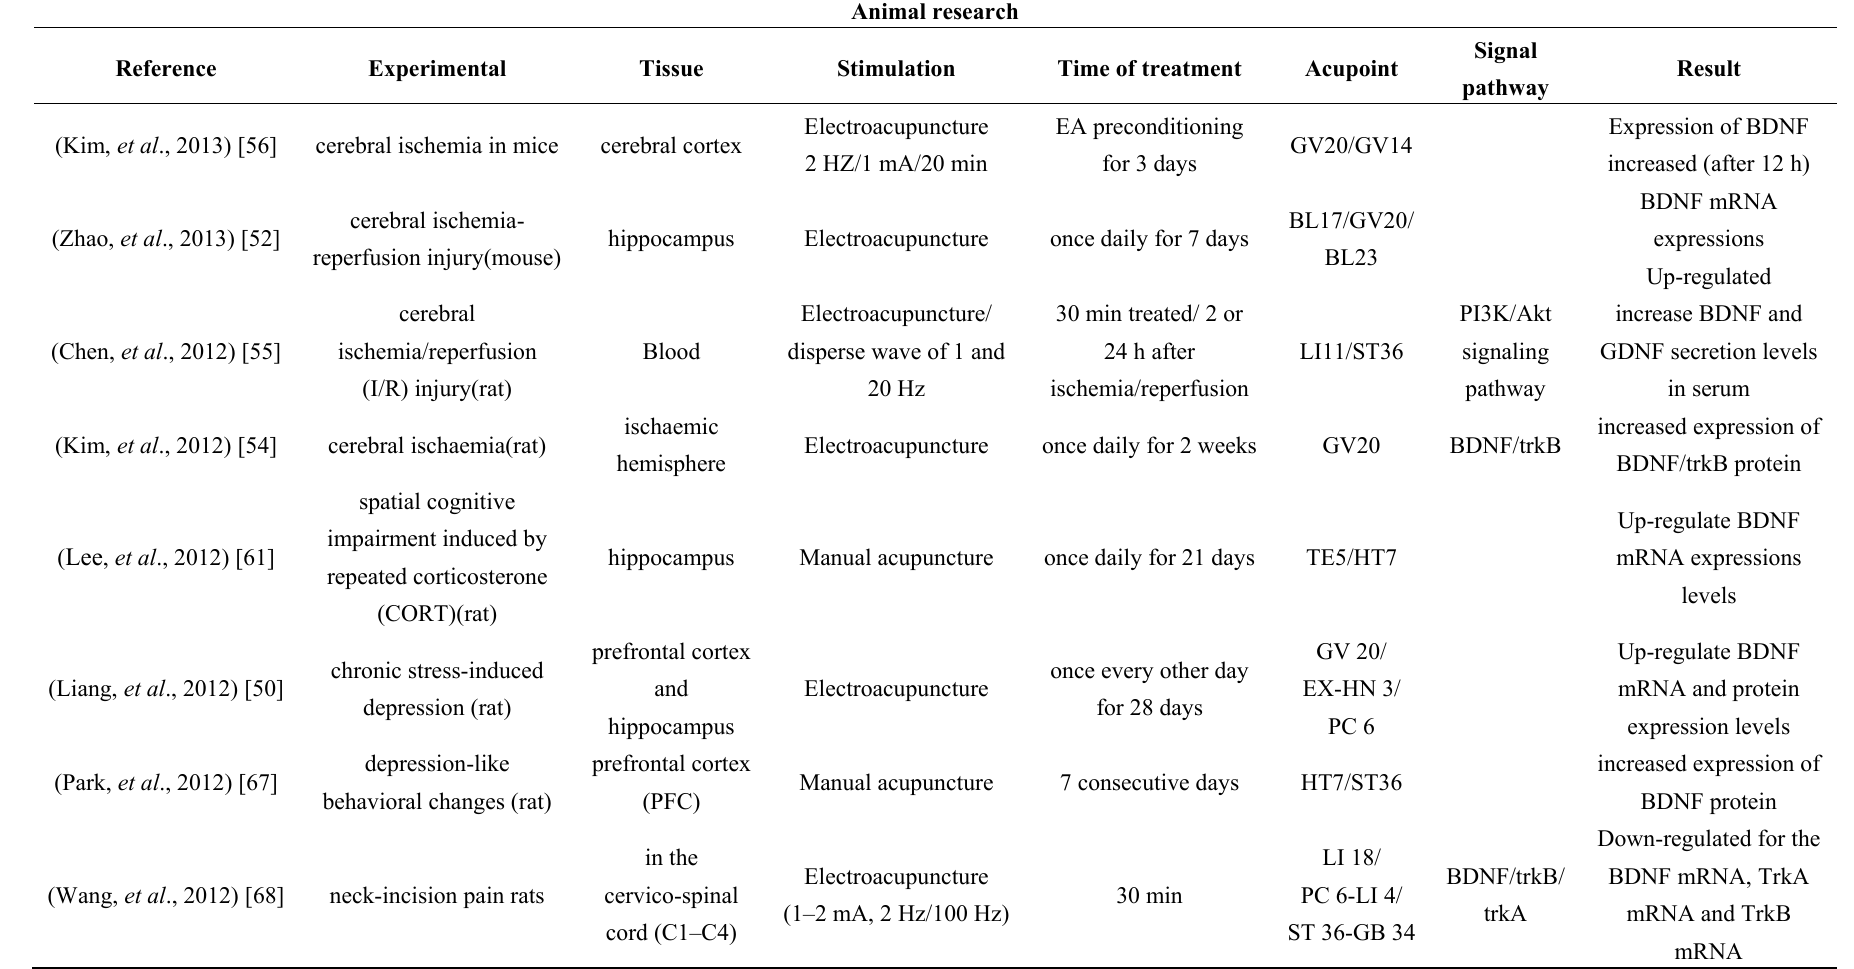
Table 1. Publications of acupuncture therapy published on PUBMED in the last 10